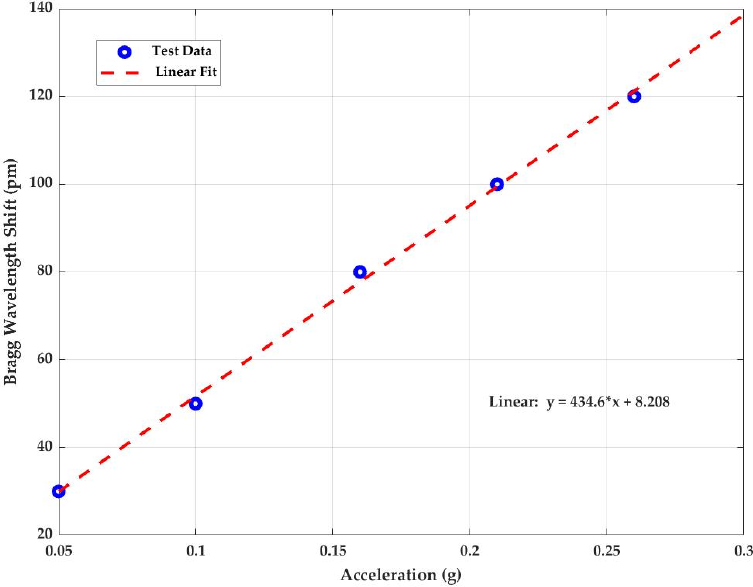
Figure 9. Linear response of Bragg wavelength shift versus applied acceleration at frequency 20